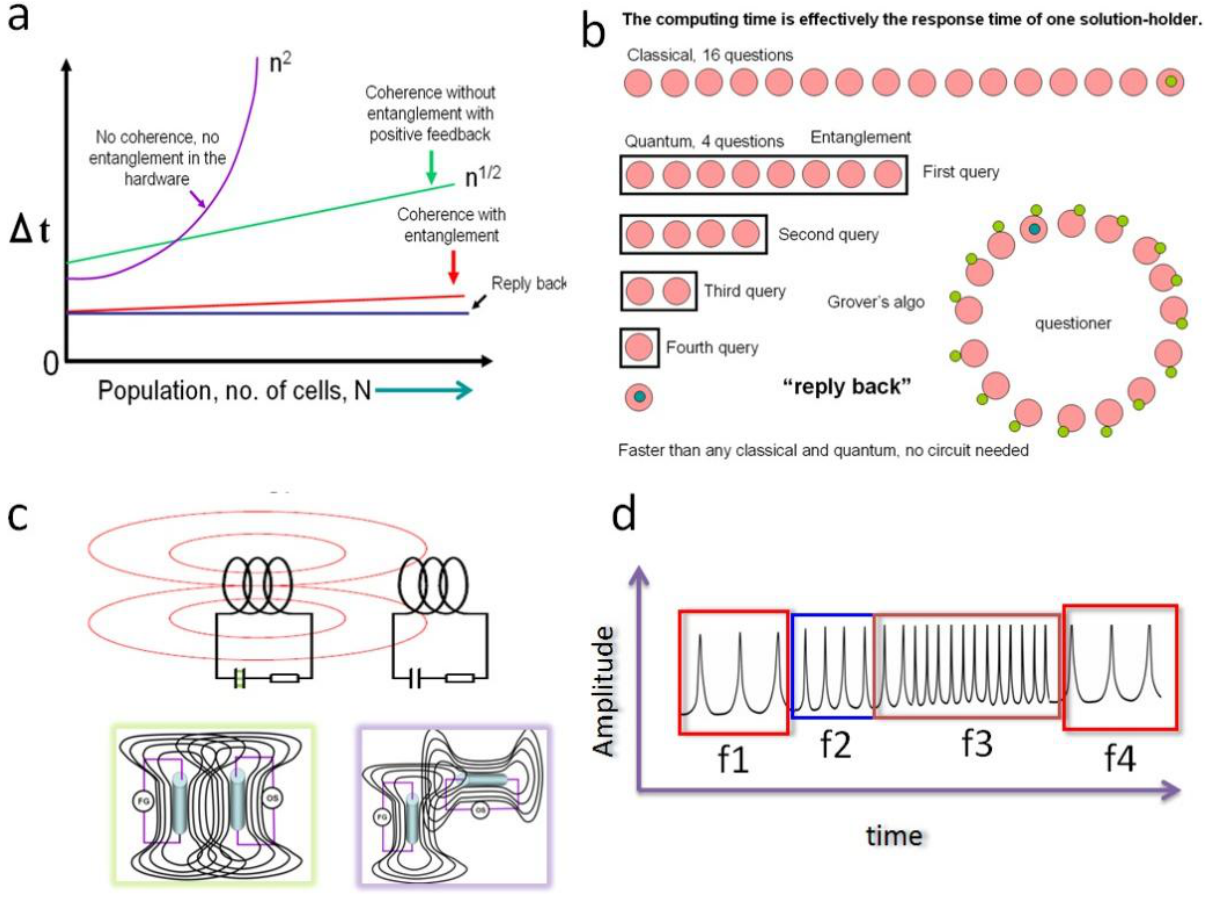
Figure 3. ( a ) Time taken for computing per step for increasing population or search space N is plotted for computing when ―coherence‖ is used by various means; ( b ) A comparison between classical, quantum and ―reply back‖ routes; ( c ) Energy transfer for two inducting coils, far distance communication are presented in different orientations; ( d ) A wave train in our computer, four frequency